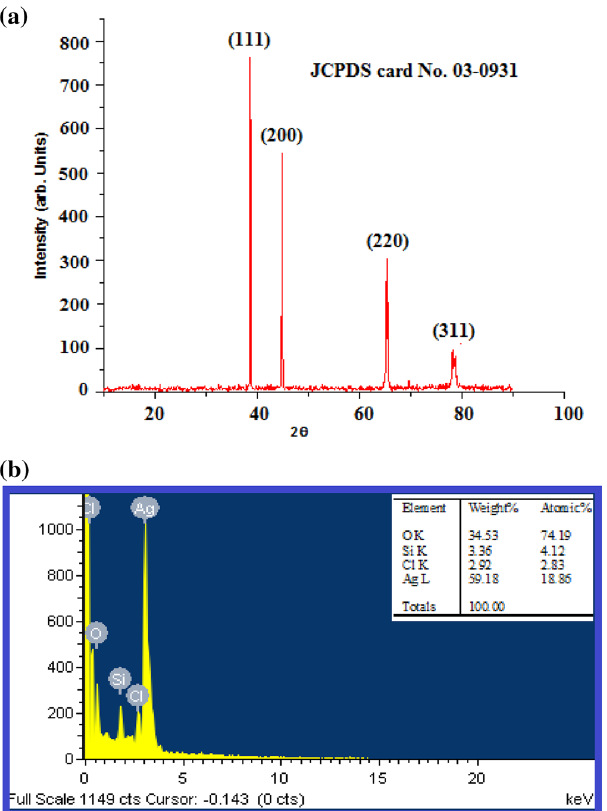
Figure 5. ( a ) XRD spectral data of biosynthesized Ds-AgNPs. ( b ) EDX analysis of fabricated Ds-AgNPs by plant extract of Drosera